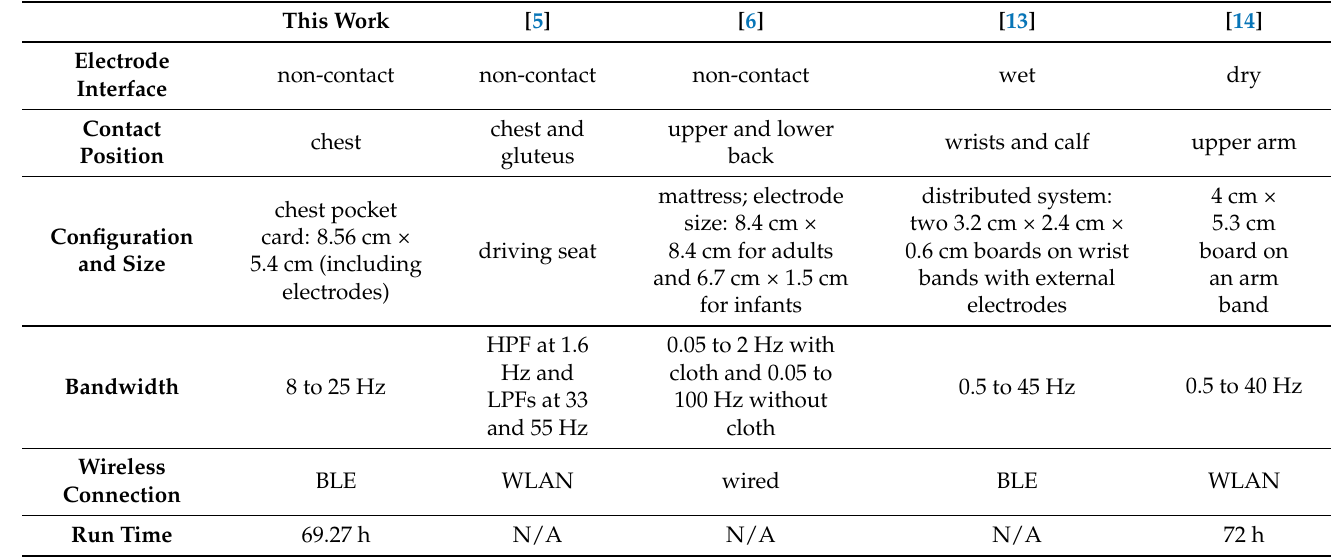
Table 1. Comparison between the proposed design and other previous